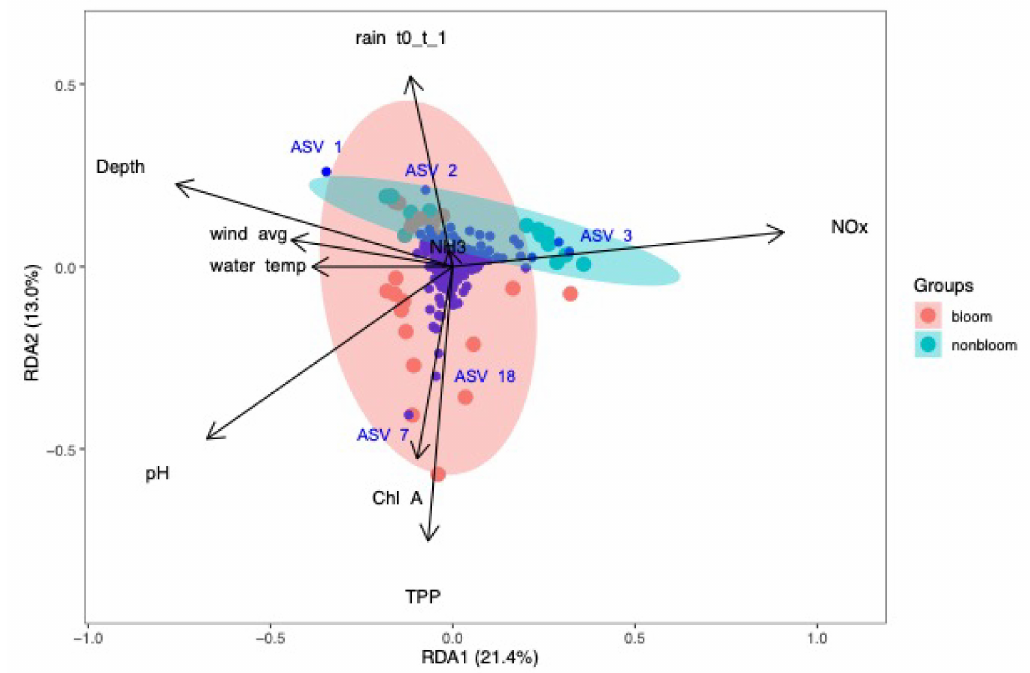
Figure 9. Redundancy analysis of bacterial community and environmental parameters for samples collected in 2017. NOx had a strong influence on non-bloom community. TPP, chlorophyll-a and pH were associated with the bloom samples. NH 3 and rain were positively